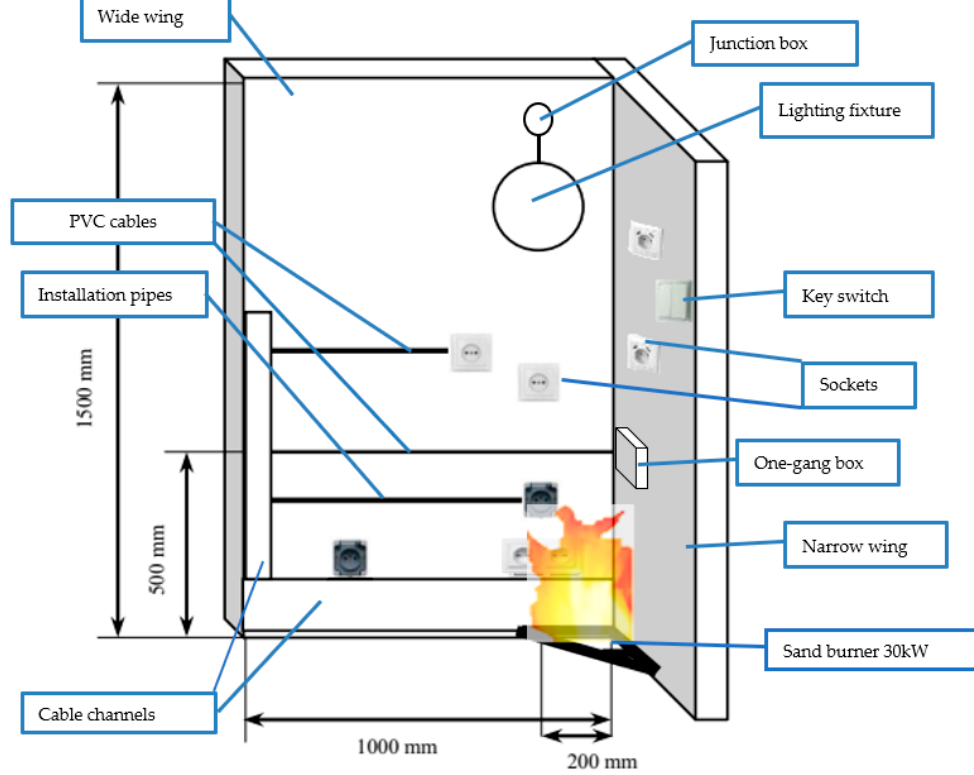
Figure 2. Overview diagram of SBI specimen with electrical installation as a component of specimen 1 (on a combustible substrate) and specimen 2 (on a non-combustible substrate).